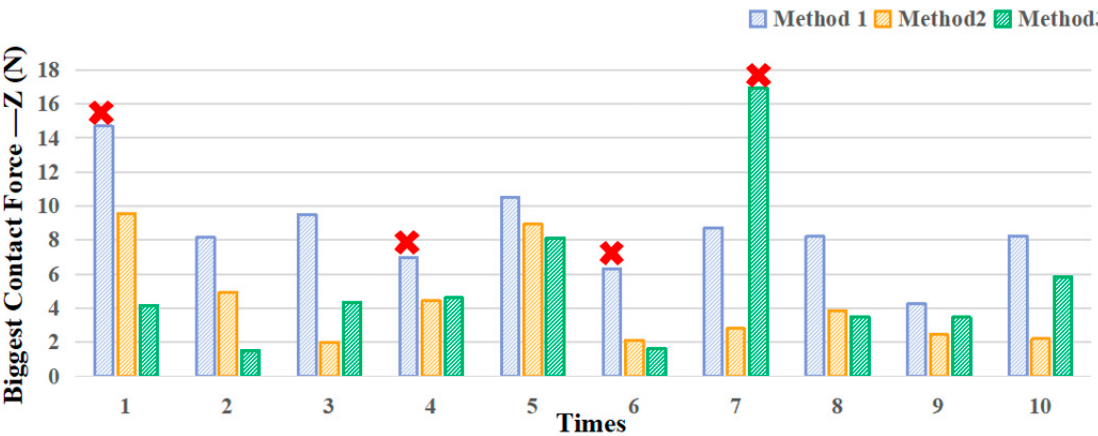
Figure 12. The maximum contact force in the X -axis of the three methods in each experiment.